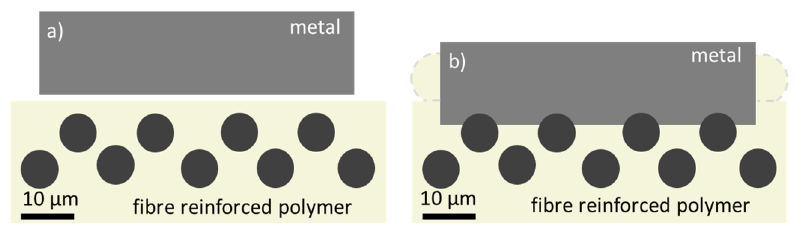
Figure 1. Schematic microstructure of an ultrasonically welded metal/fiber reinforced polymers (FRP)-joint ( a ) before and ( b ) after ultrasonic metal welding process (FRP)-joint ( a ) before and ( b ) after ultrasonic metal welding process [17–19]. The comparison of joint strength between adhesive bonding and ultrasonic welding is common and also practicable for tubular hybrid structures. Assuming perfect surface